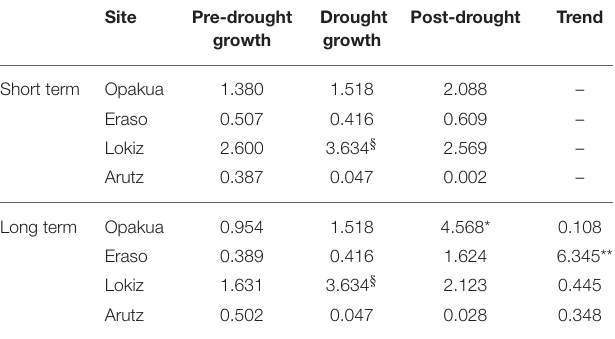
TABLE 2 | Short-term (three-years long) differences in pre- and post-drought growth (basal area increment) values between declining and non-declining beech individuals in the four beech study sites in response to the 2003–2005 drought.